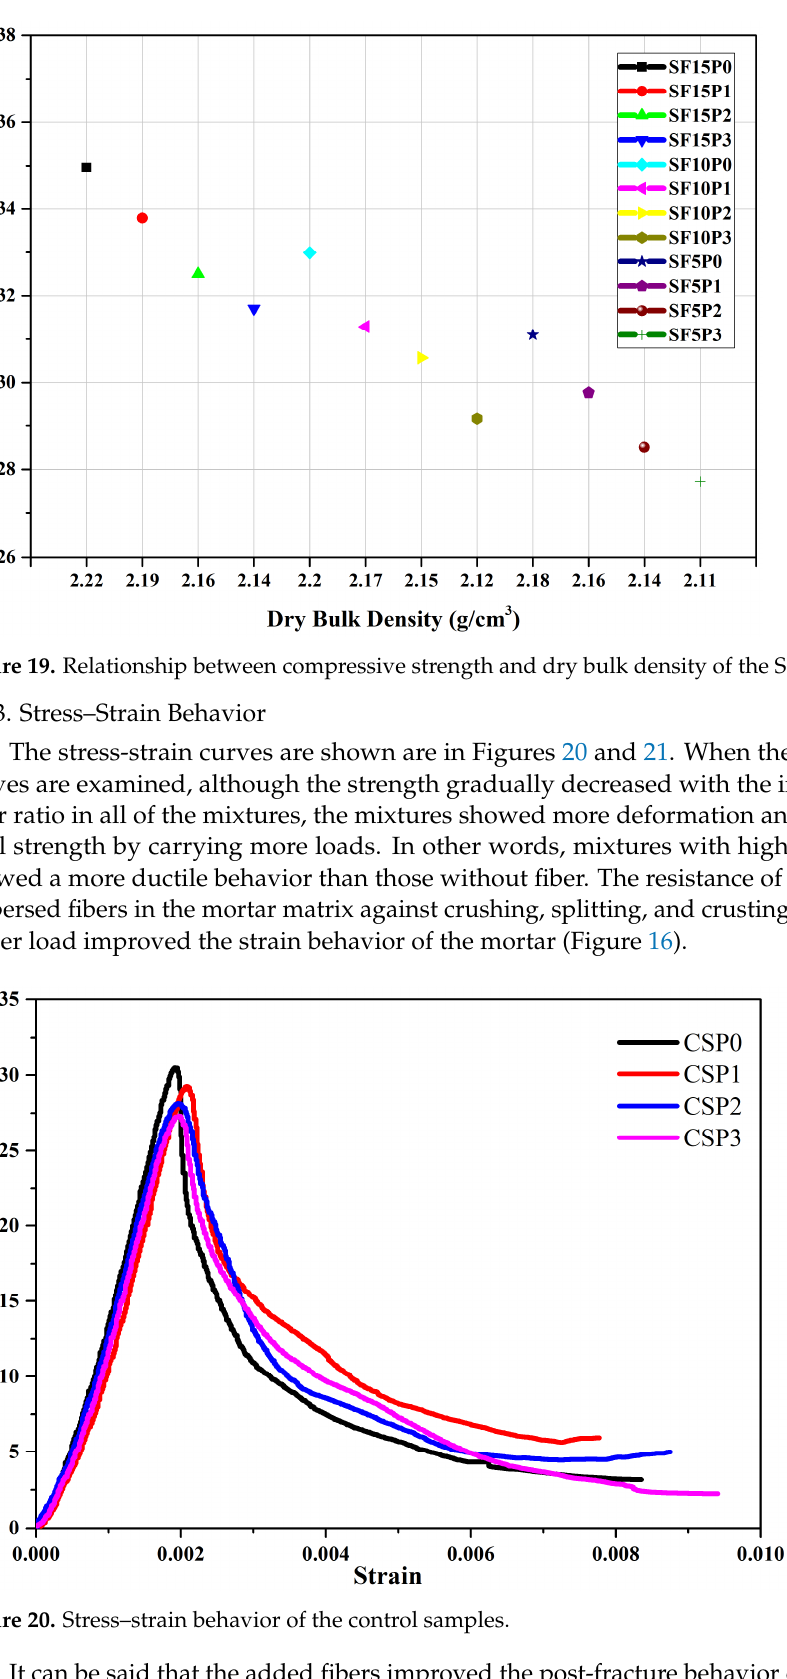
Figure 18. Relationship between compressive strength and dry bulk density of the MS samples.